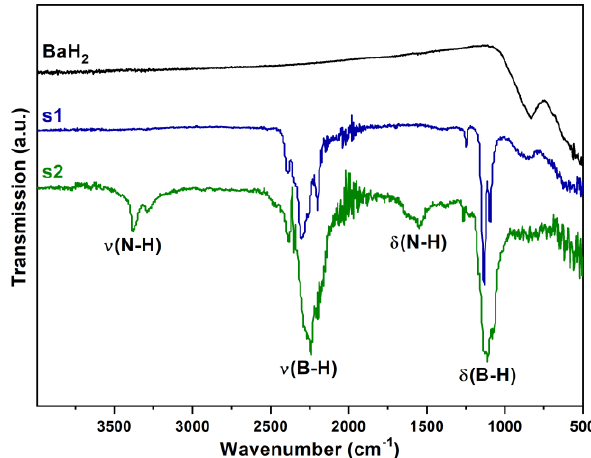
Figure 1. FT-IR spectra of BaH 2 , s1 (Ba(BH 4 ) 2 ) and s2 (Ba(BH 4 ) 2 ·2NH 3 ).